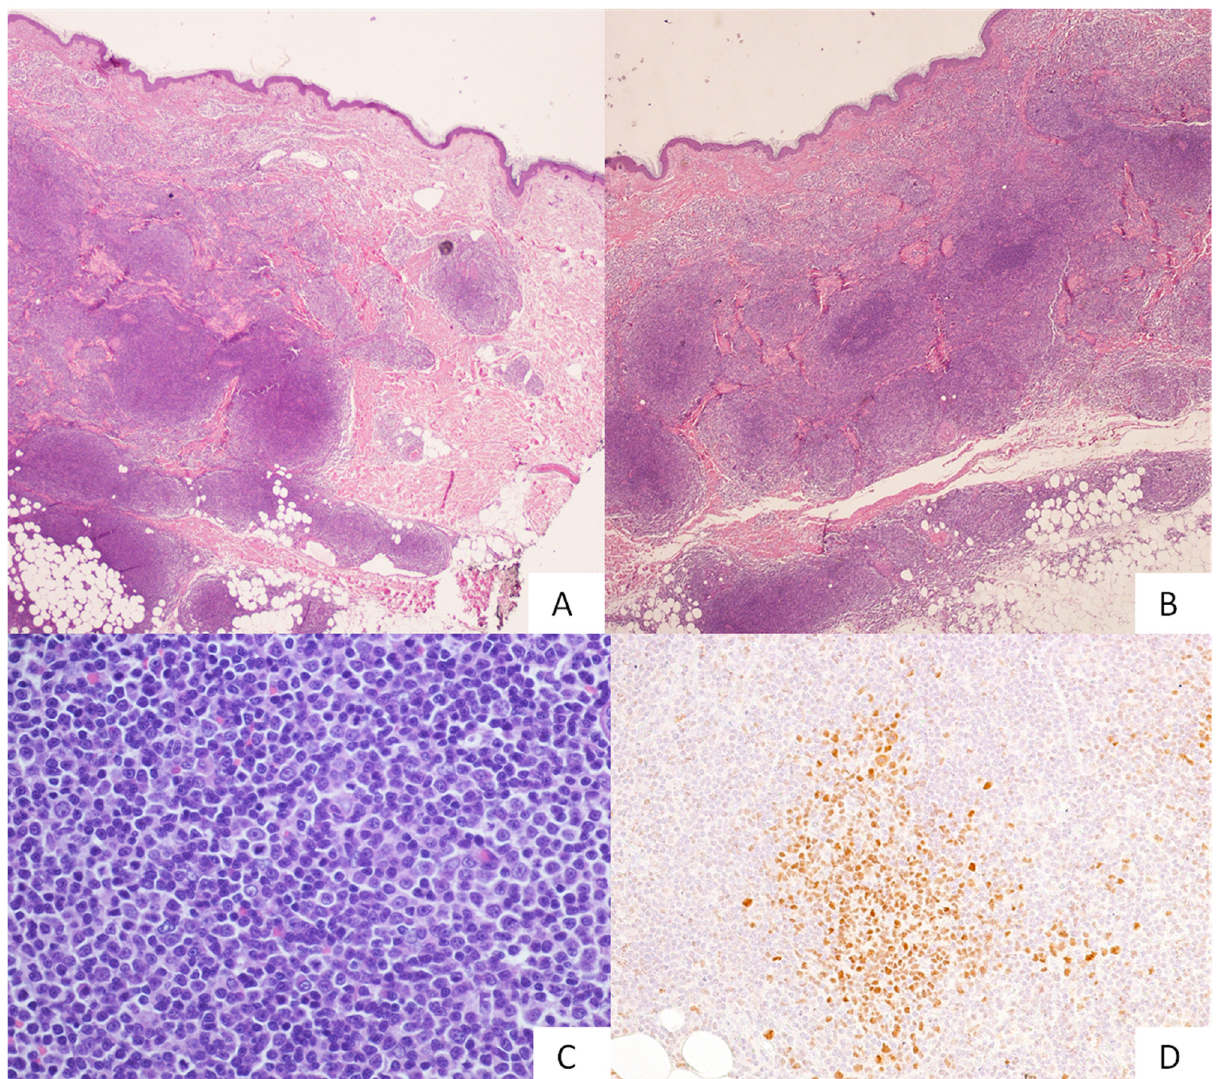
Figure 2. PCFCL. At histological evaluation, this lymphoma shows a nodular growth pattern (( A ), HE 2×), sometimes nodular and vaguely diffuse (( B ), 2×), composed of an admixture of centrocytes (( A ), HE 2 × ), sometimes nodular and vaguely diffuse (( B ), 2 × ), composed of an admixture of and centroblasts (( C ), HE 40×), and is usually bcl6 ‐ positive (( D ), 10×). centrocytes and centroblasts (( C ), HE 40 × ), and is usually bcl6-positive (( D ), 10 × PCFCL populations consist of an admixture of centrocytes and centroblasts.